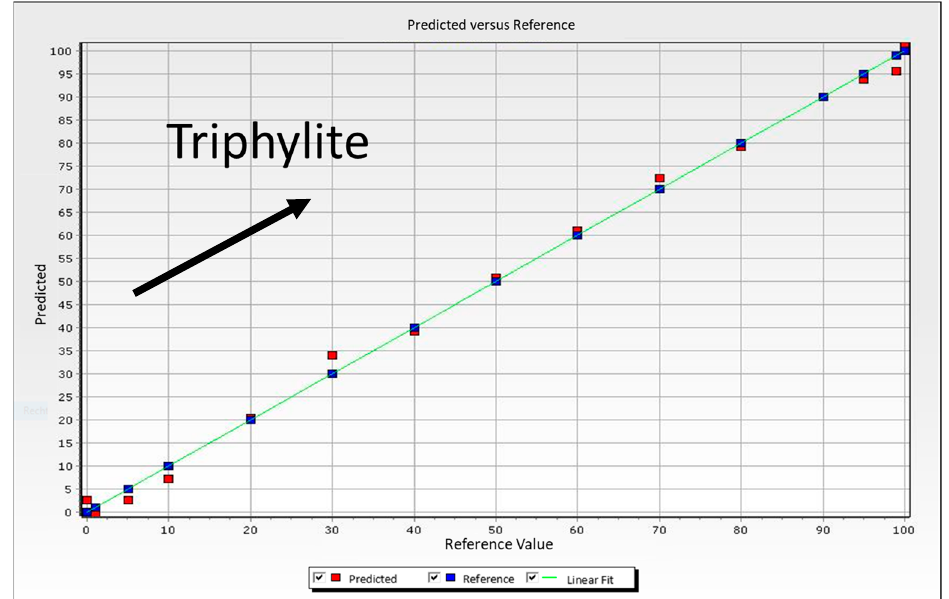
Figure 11. Calibration curve for triphylite–quartz mixtures.